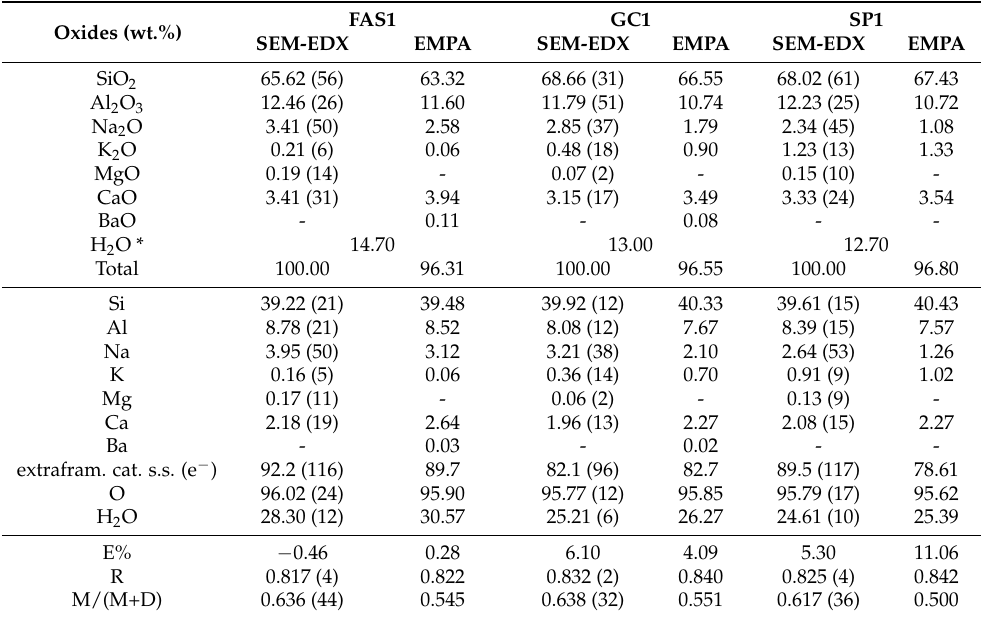
Table 2. SEM-EDX and EMPA chemical analyses of the mordenite samples.